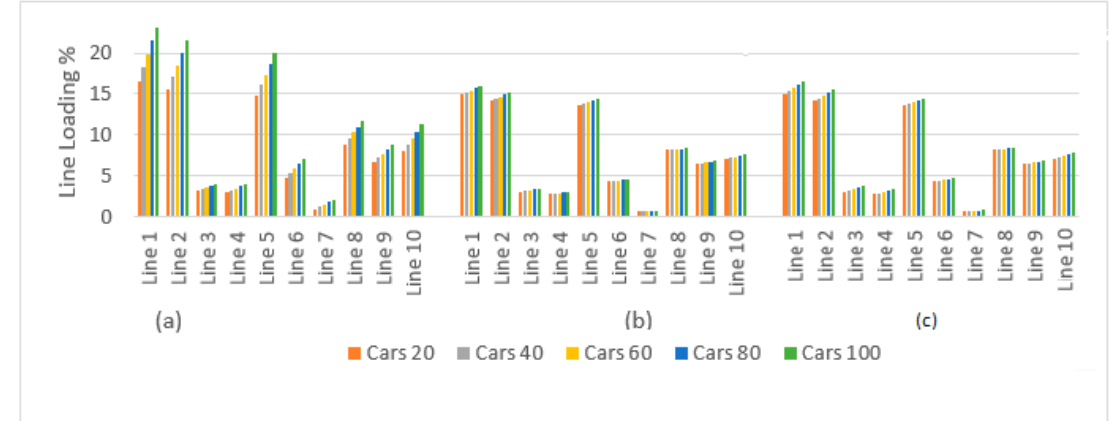
Figure 12. Average observed line loading—( a ) unoptimized versus, ( b ) optimized for minimizing peak line loading across all lines per vehicle with no limit on configuration, and ( c ) optimized for minimizing peak line loading across all lines per vehicle with no charging station having more than 25% of the vehicles charging at that hour.